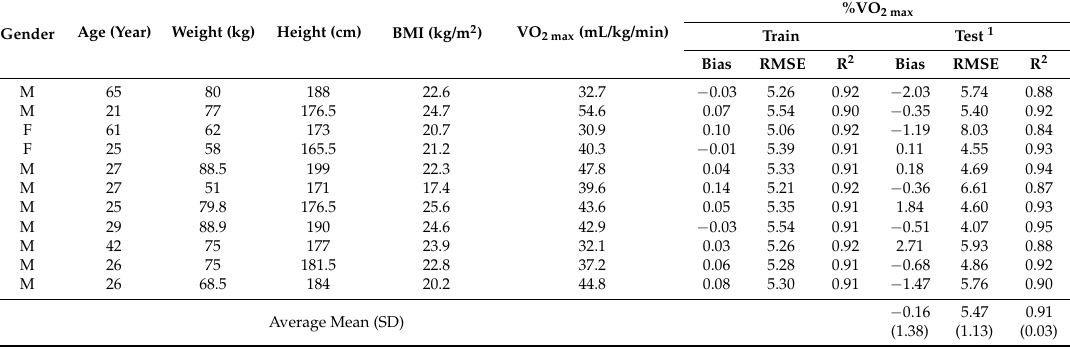
Table 5. Results of the cross validation of the relative VO 2 (%VO 2 max ) from the neural network.